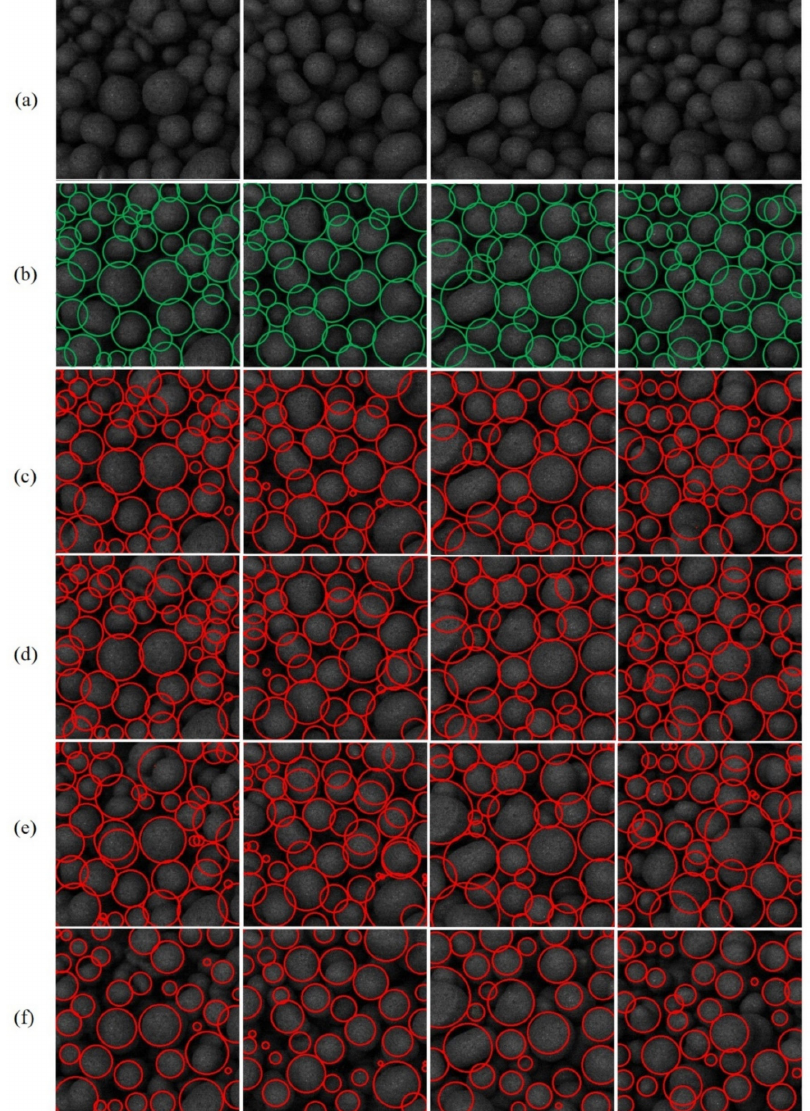
Figure 9. Comparison of different segmentation algorithms. ( a ) Original image. ( b ) Manual marked method results. ( c ) Proposed algorithm segmentation results. ( d ) K-means algorithm segmentation results. ( e ) Meanshift algorithm segmentation results. ( f ) Watershed